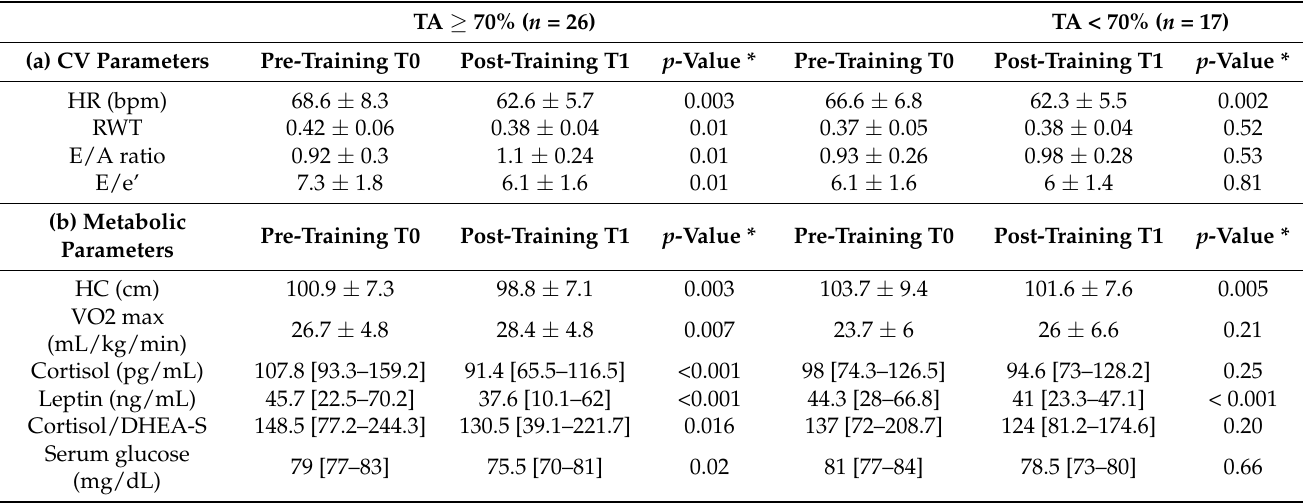
Table 2. Comparison of cardiometabolic parameters between groups, by